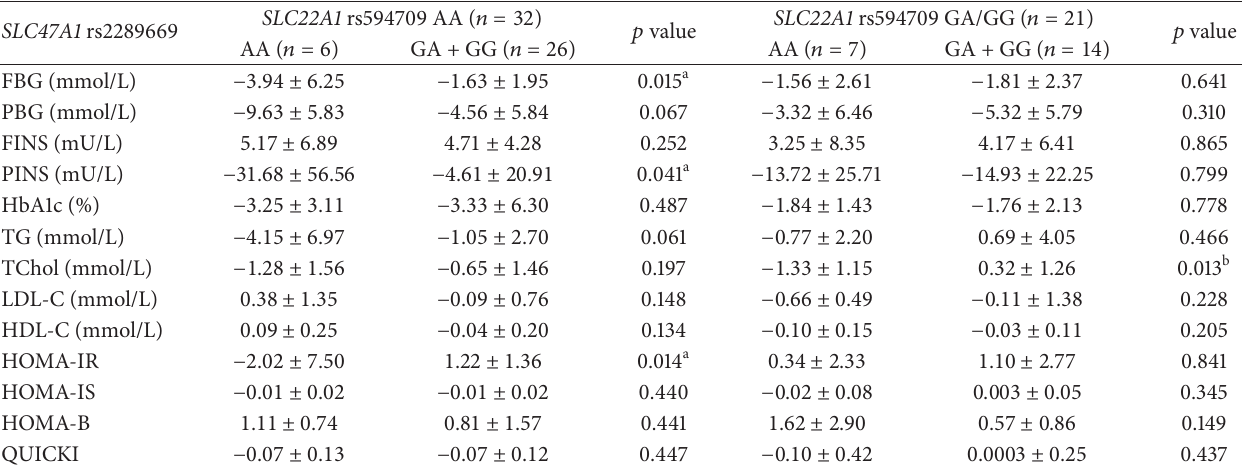
Table 4: The differential values (DV) of clinical characteristics per SLC22A1 rs594709 and SLC47A1 rs2289669 genotypes. SLC47A1